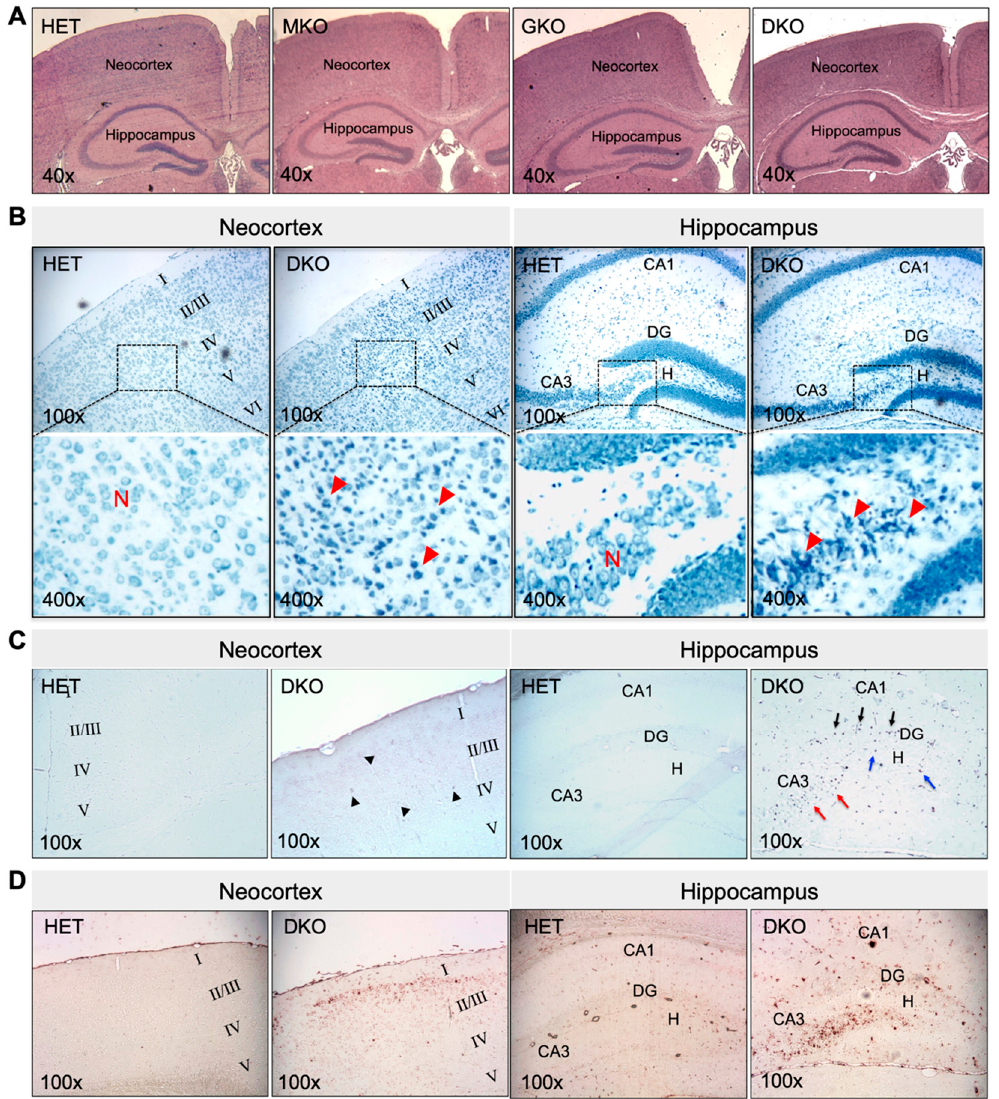
Figure 2. Young DKO mice show neuronal death and glial proliferation in the neocortex and hippocampus at PND18-20. ( A ), Representative images of HE staining of paraffin-embedded brain coronal sections from HET, MKO, GKO and DKO mice. ( B ), Representative images of TBO staining of paraffin-embedded brain coronal sections from HET and DKO mice. The square area in the top panel was enlarged in the lower panel . Loss of neurons ( N ) and reactive glial proliferation ( red arrow heads ) were noted in the neocortex and the hippocampal DG/CA3-H fields of DKO brains. ( C ), Representative images of TUNEL staining of paraffin-embedded brain coronal sections from HET and DKO mice. TUNEL-positive (apoptotic) cells were sporadic in the neocortex ( black arrow heads ) and more predominant in the CA3 ( red arrows ) and DG/H regions ( blue arrows ) and in the DG granule-cell layer ( black arrows ) of DKO brains. ( D ), Representative images of IHC detection of GFAP (a marker for astroglial cells) in the neocortex and the hippocampus of HET and DKO brains. HE, hematoxylin and eosin; N , neurons; TBO, toluidine blue O; DG, dentate gyrus; CA3-H, cornu ammonis-3; H, hilus; TUNEL, terminal deoxynucleotidyl-transferase-mediated dUTP nick-end-labeling; IHC, immunohistochemistry; GFAP, α -glial fibrillary acid protein. Magnifications: 40×, 100×, and 400× as indicated.